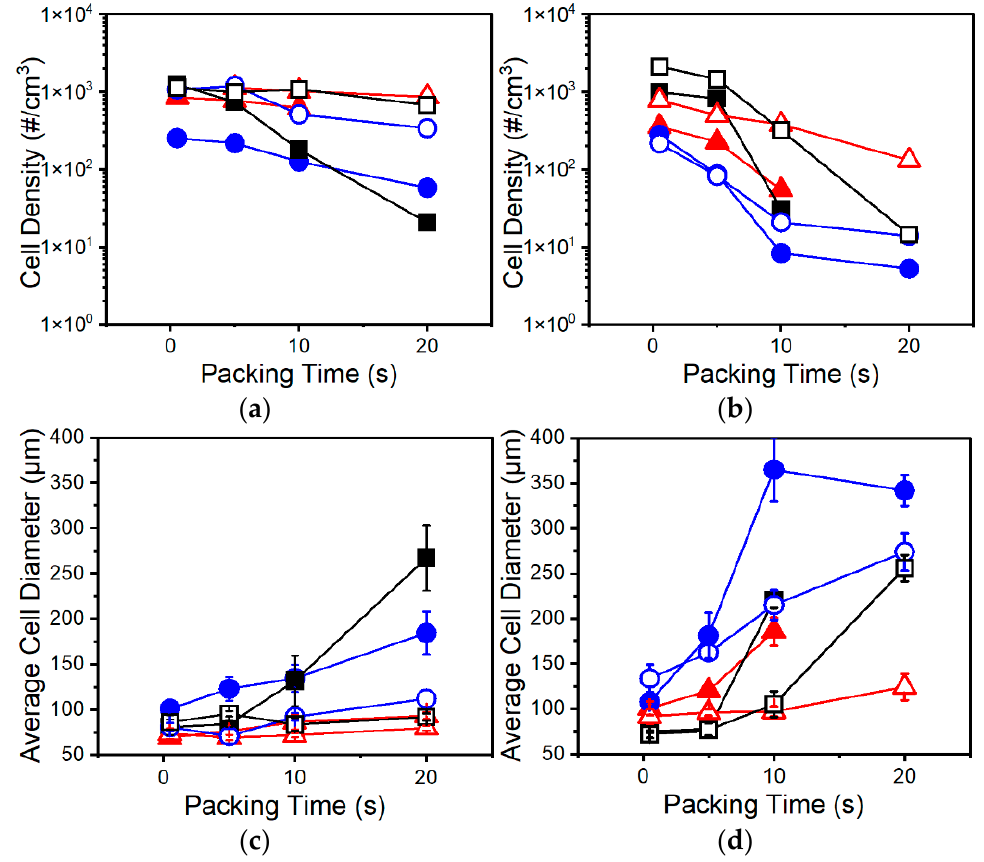
Figure 5. Cell density ( a , b ), and average cell diameters ( c , d ) of Resin A (red triangles), Resin B (blue circles), and Resin C (black squares) samples foamed using: ( a , c ) AV CBA and ( b , d ) UC CBA under various packing times. Closed and open symbols indicate 1 wt% and 2 wt% CBA, respectively.